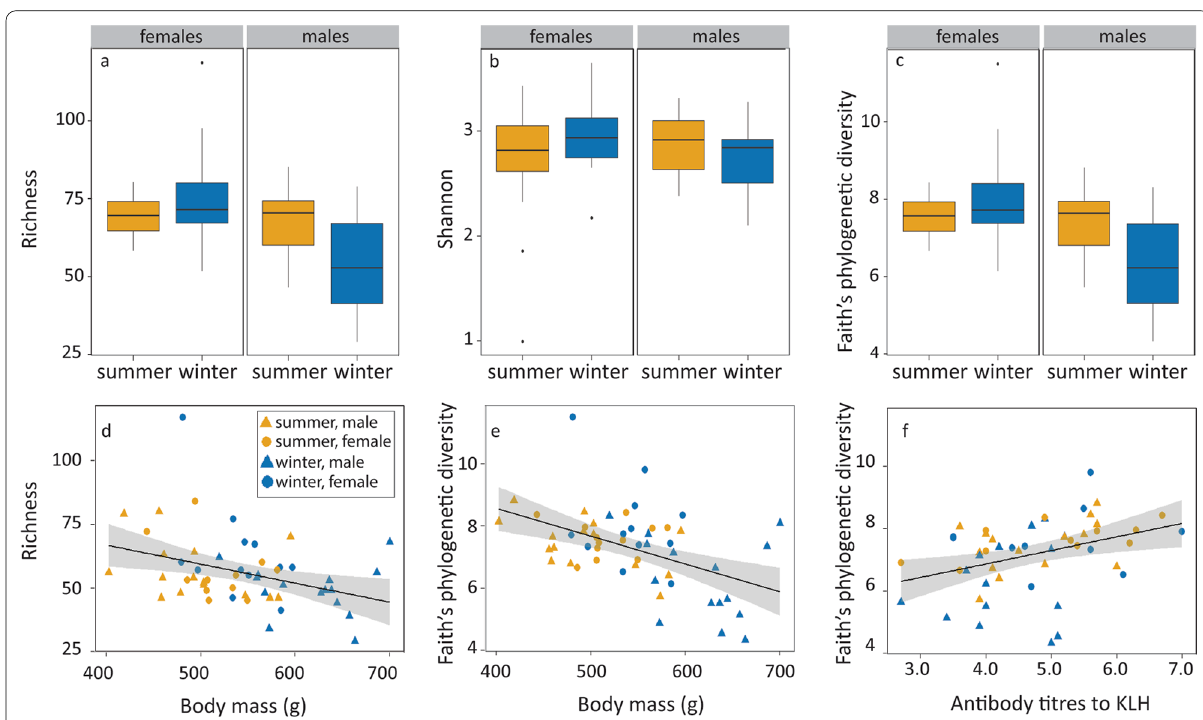
Fig. 3 Relationships between alpha-diversity indices and season and sex, and metabolism and immune indices. The boxplots present seasonal and sexual variation for a richness, b Shannon diversity, and c Faith’s phylogenetic diversity. Richness and Faith’s phylogenetic diversity both decreased with increasing body mass d , e , while Faith’s phylogenetic diversity also increased with titres of antibodies against KLH f . Statistics are presented